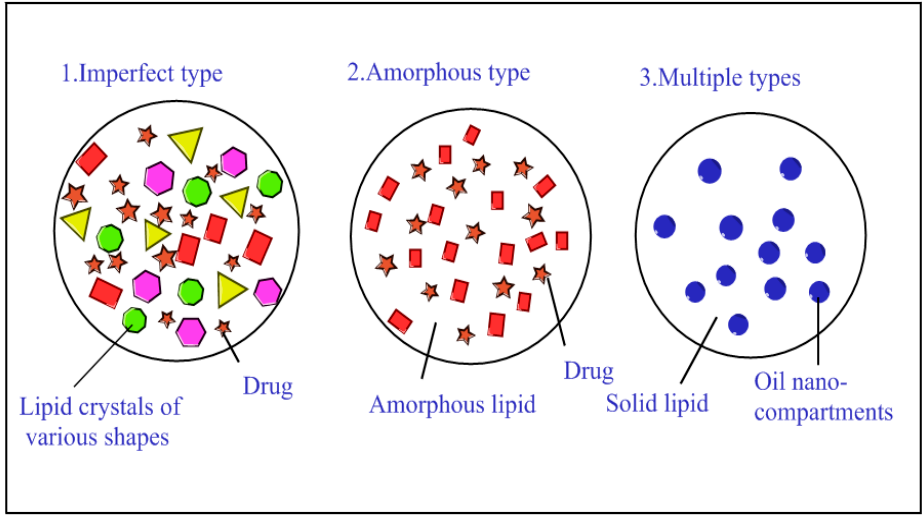
Figure 1. Schematic diagram illustrating structures of NLCs (1, 2, and 3 are disorder structure, amorphous structure and multiple structure, respectively).